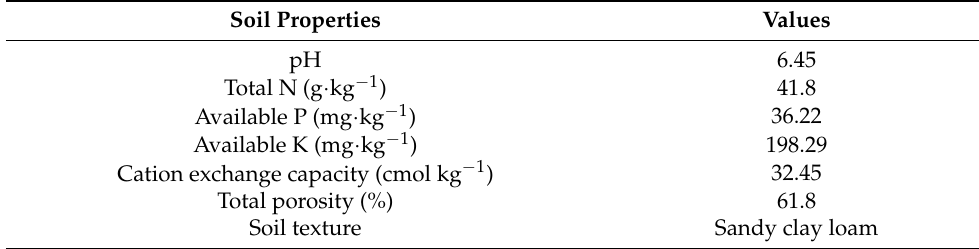
Table 1. The properties of the soil.